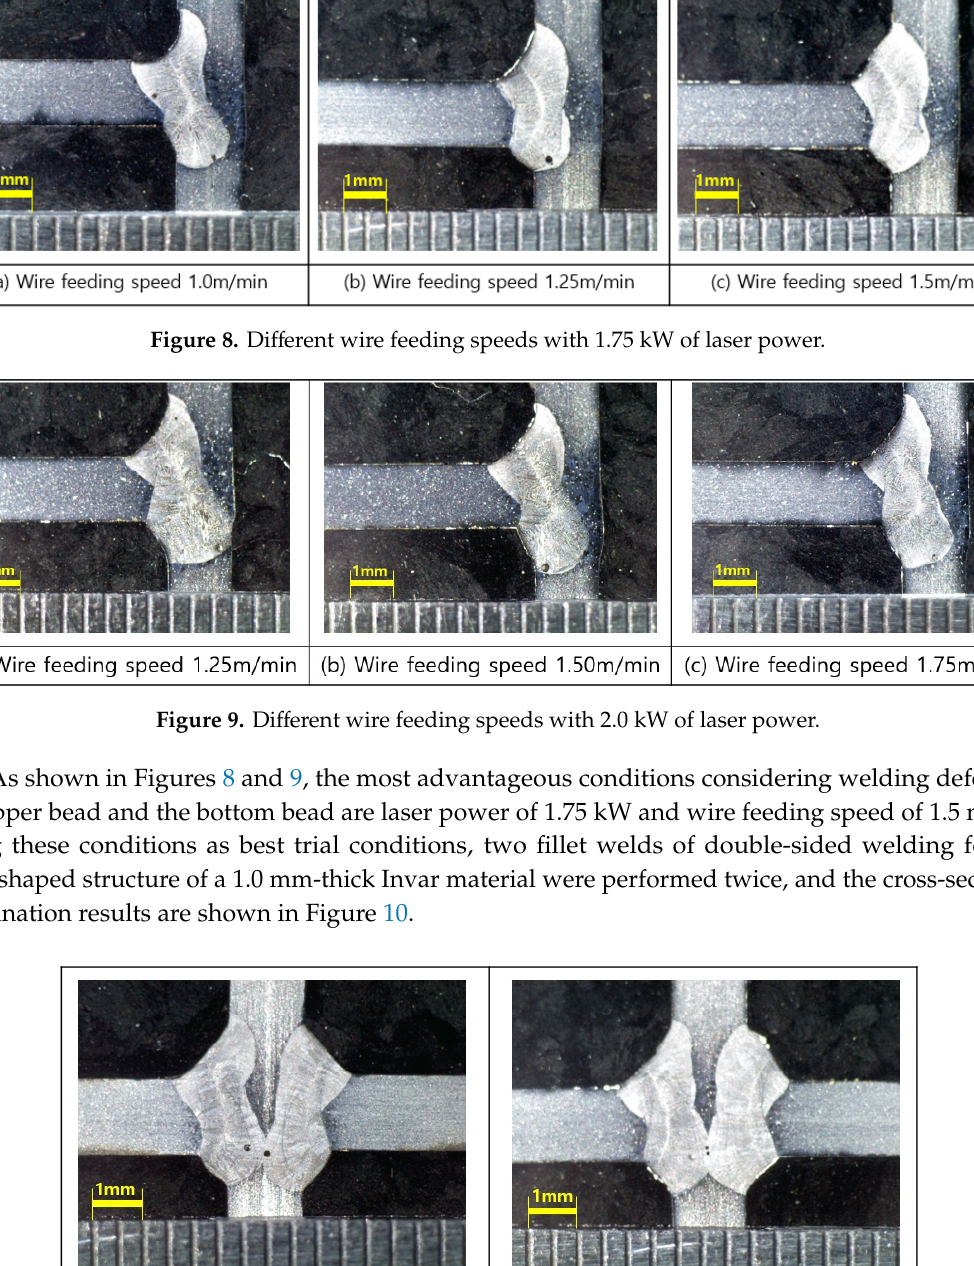
Figure 10. Final result of 1.5 mm thickness Invar.